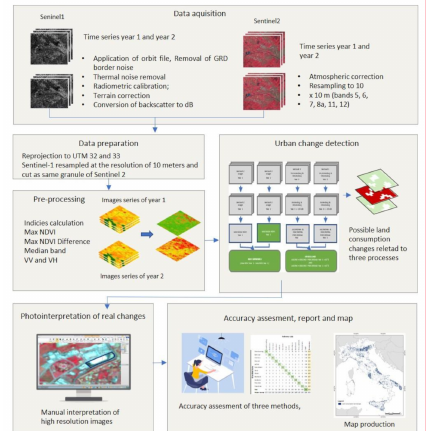
Figure 1. Overview of the classification